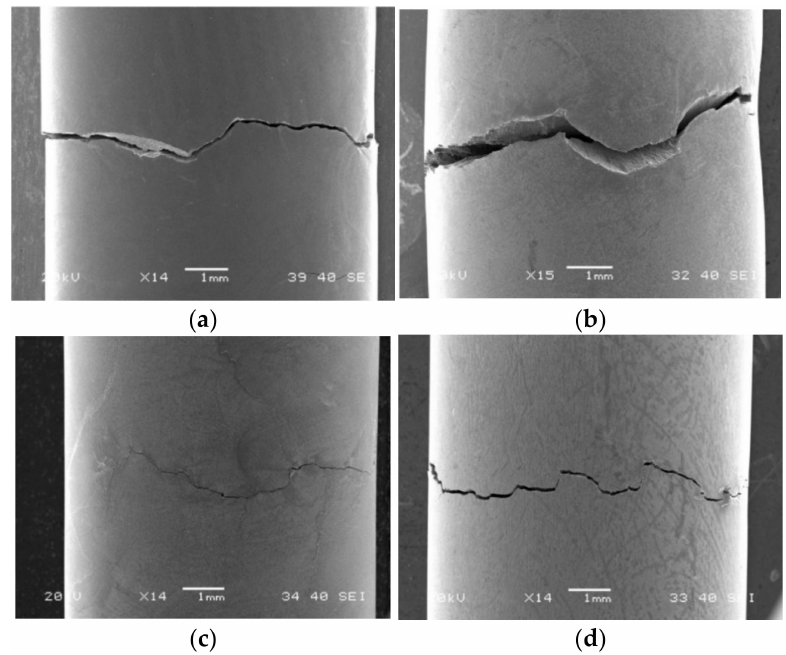
Figure 7. Surface crack morphology of LCF specimens tested at the strain amplitude of 0.8% and the strain rate of: ( a ) 0.4%/s in air at RT, ( b ) 0.004%/s, ( c ) 0.04%/s and ( d ) 0.4%/s in high tempera- ture